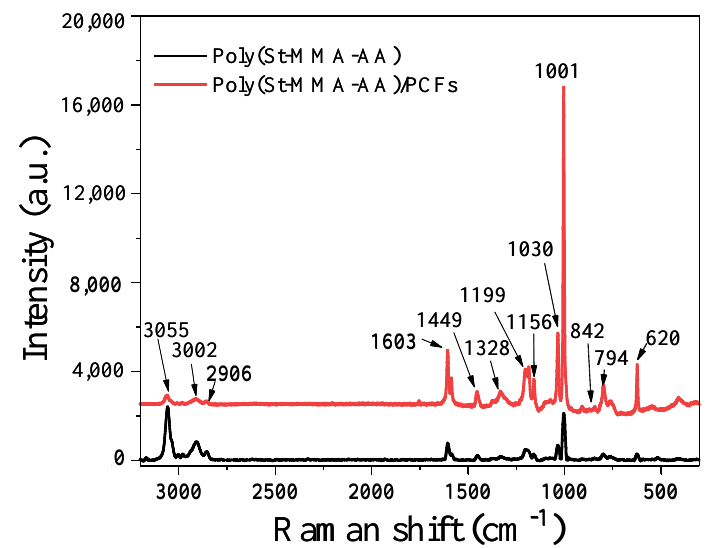
Figure 4. Raman spectra of 308.3 nm-diameter Poly(St-MMA-AA) nanoparticles prepared on aluminium substrate adhering to the surface of a coverslip and Poly(St-MMA-AA)/PCFs made of 308.3 nm-diameter Poly(St-MMA-AA) nanoparticles. The laser focus is centred within the nanoparticle